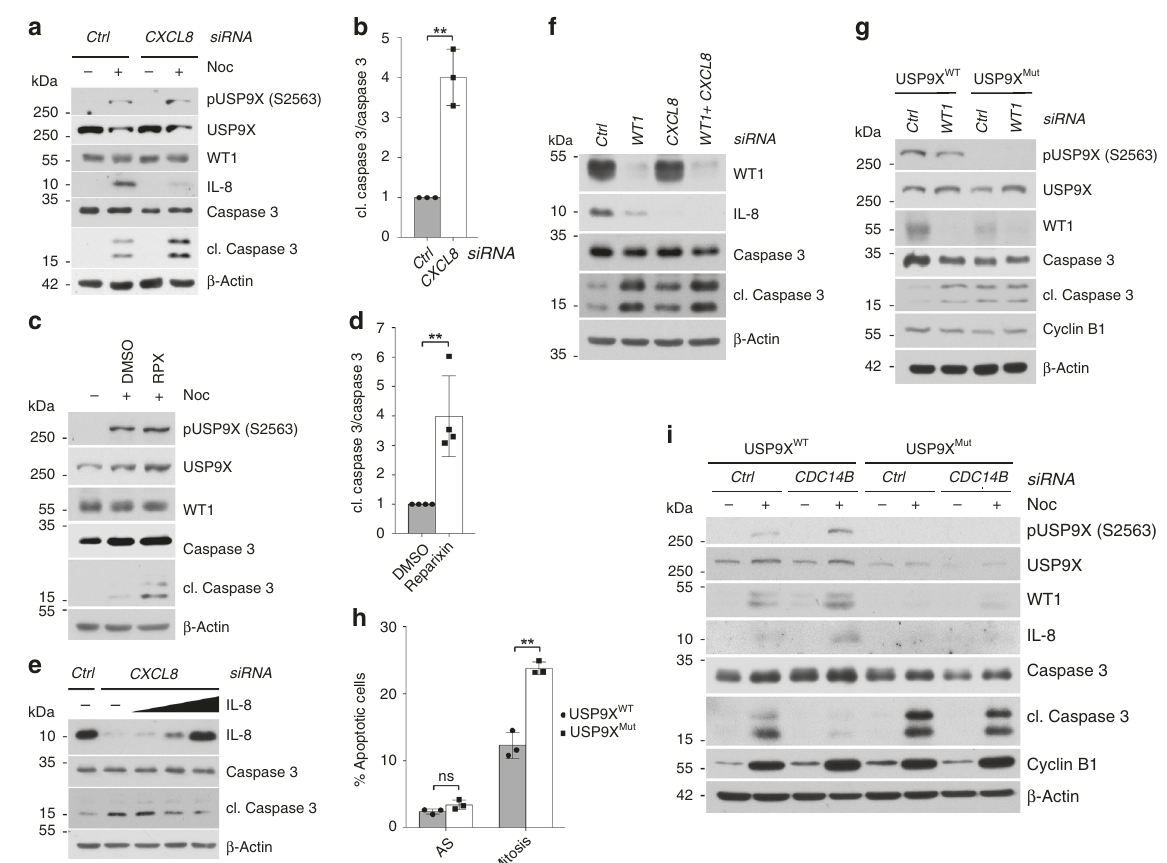
Fig. 4 CDK1/CDC14B-dependent phosphorylation of USP9X at serine 2563 promotes mitotic survival via WT1 and IL-8. a Mitotic apoptosis in response to CXCL8 versus control knockdown detected by immunoblot in U2OS cells that were treated with the respective siRNA and arrested in mitosis using nocodazole for 8 h. Samples were collected, lysed, and analyzed by western blot with the indicated antibodies. b Quanti fi cation of relative amount of cleaved caspase 3 in n = 3 biologically independent experiments conducted as described in a . Ratio paired t -test was applied with ** p = 0.0055. c Immunoblot analysis showing increased mitotic apoptosis in U2OS cells in response to treatment with nocodazole (8 h) and the CXCR1/2 inhibitor reparixin (RPX) or DMSO for 48 h. d Quanti fi cation of relative amount of cleaved caspase 3 in n = 4 biologically independent experiments conducted